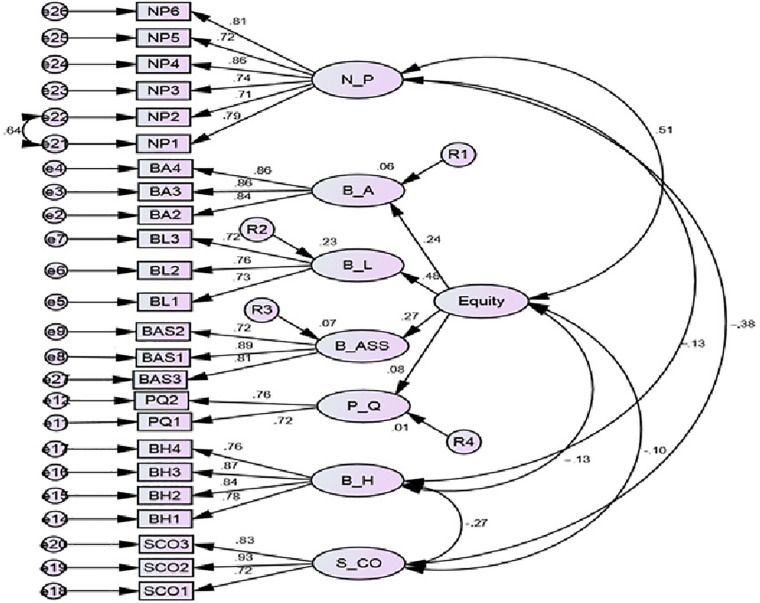
Structural model